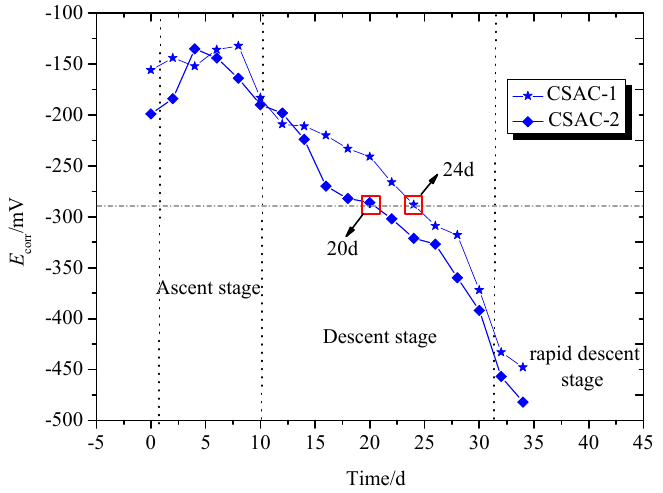
Figure 4. Time-varying curve of corrosion potential of reinforcement in CSAC.